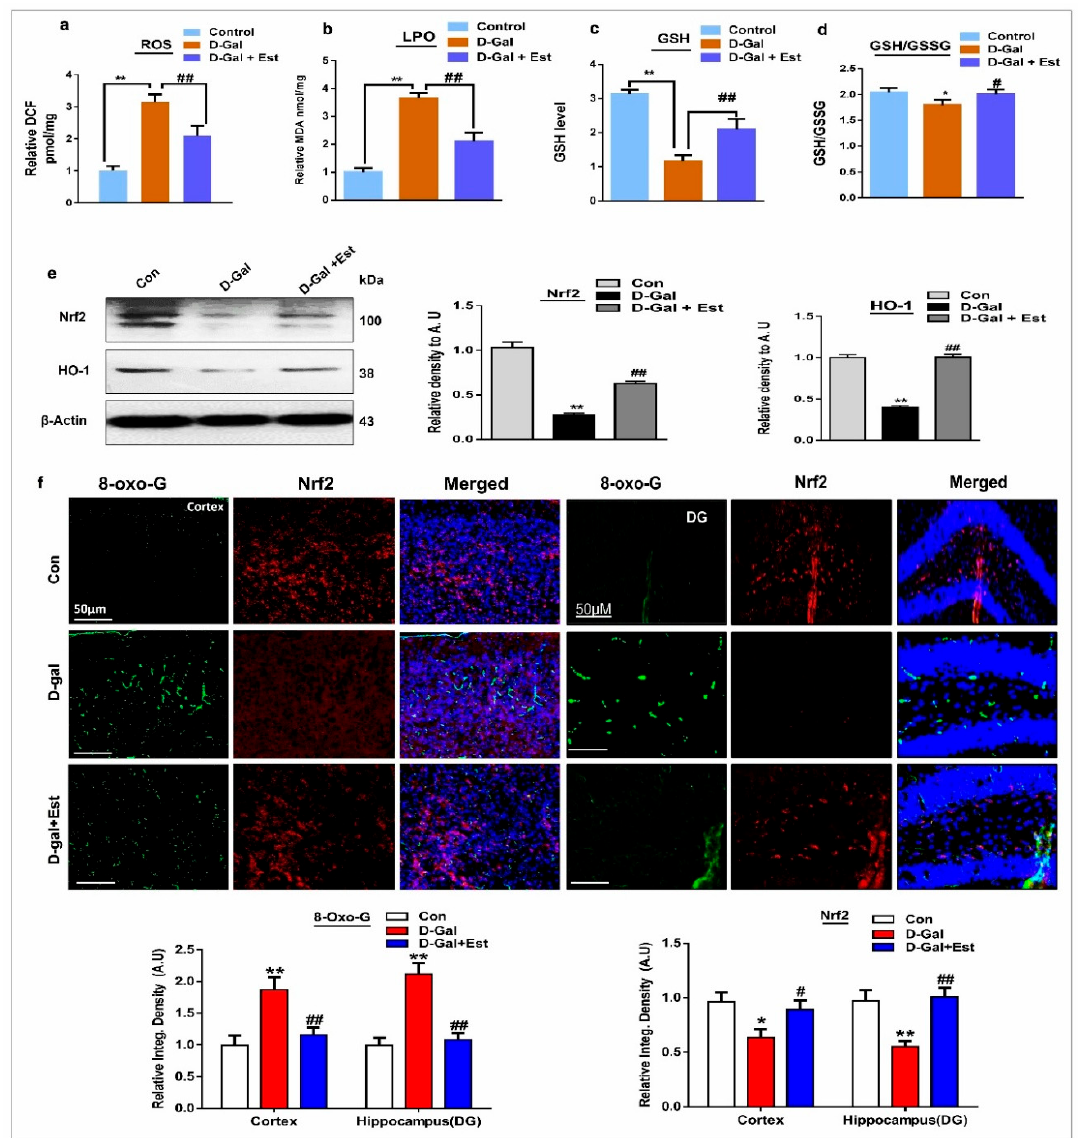
Figure 1. 17 β -estradiol attenuated the D -gal-induced increase in oxidative stress in adult mice brain. ( a ) The histogram of the reactive oxygen species (ROS) level in the brain homogenates of the adult mice. ( b ) A histogram represents the malondialdehyde (MDA) level in the brain homogenates of the adult mice. n = 7–8 mice / group, and the experiments were repeated in triplicate. ( c ) The representative histograms showing the glutathione (GSH) levels, and ( d ) GSH / glutathione disulfide (GSH / GSSG) ratio levels in the brain homogenates of the adult mice. ( e ) Shown are the Western blots results of nuclear factor erythroid 2-related factor 2 (Nrf2) and heme oxygenase-1 (HO-1) along with respective histograms in the brain homogenates of adult mice of all experimental groups. β -Actin was used as a loading control. ( f ) Representative images of immunofluorescence staining of colocalization of 8-Oxoguanine (8-OxoG) and Nrf2 in the cortex and hippocampus of the adult mice. n = 7–8 mice / group, and the number of experiments = 3. Magnification × 40. Scale bar = 100 µ m. The data are shown here as a mean ± S.E.M. * significantly di ff erent from the control group; and # significantly di ff erent from D -gal-treated group, respectively; * & # p < 0.05, ** & ## p < 0.01.